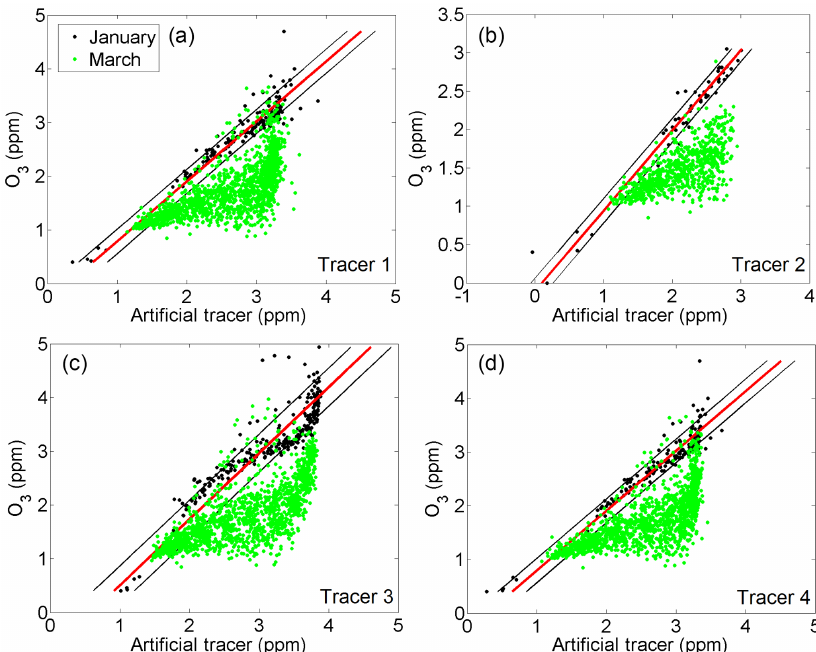
Figure 3. Artificial tracer correlation technique using ACE-FTS measurements inside the polar vortex in January (black dots) and March (green dots) 2011 using (a) Tracer 1, (b) Tracer 2, (c) Tracer 3, and (d) Tracer 4. The fitted correlations are shown as red lines, and the black lines indicate the ± 1 σ standard deviation of the fit. See text for further details on the artificial